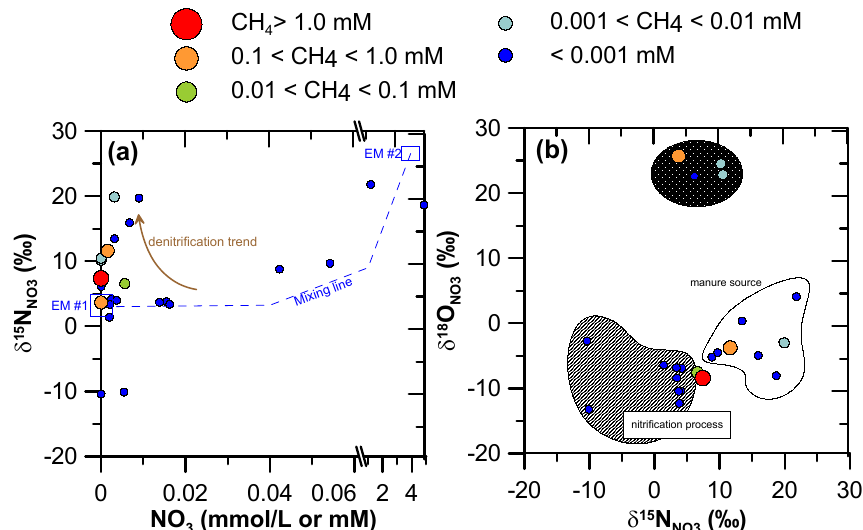
Figure 8. Cross plot of δ 15 N NO and δ 18 O NO values with N-NO 3 concentrations (mM) and identification of three groups of data according 3 3 to nitrate origin and formation processes. Dissolved methane concentration is reported as colored